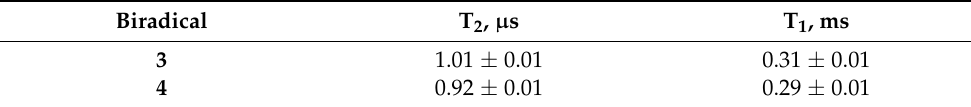
Table 2. Parameters of relaxation times for biradicals 3–4.